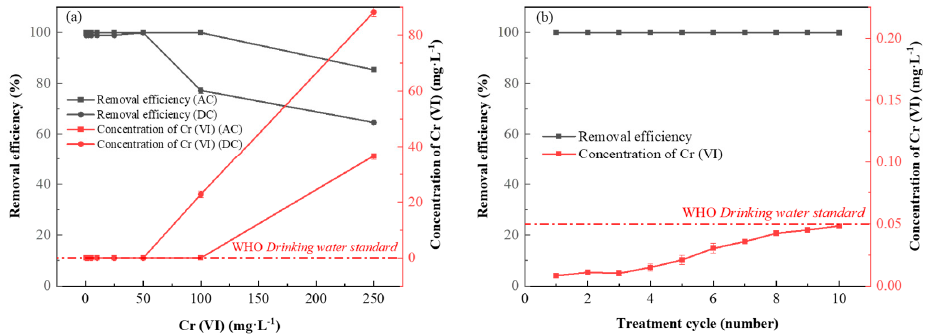
Figure 6. ( a ) Comparison of Cr (VI) removal by direct current (DC) and alternating current (AC) ods. ( b ) Cr (VI) removal as the function of treatment cycle by Ami-CF in the long-term methods. ( b ) Cr (VI) removal as the function of treatment cycle by Ami ‐ CF in the long ‐ term experi ‐ ment.